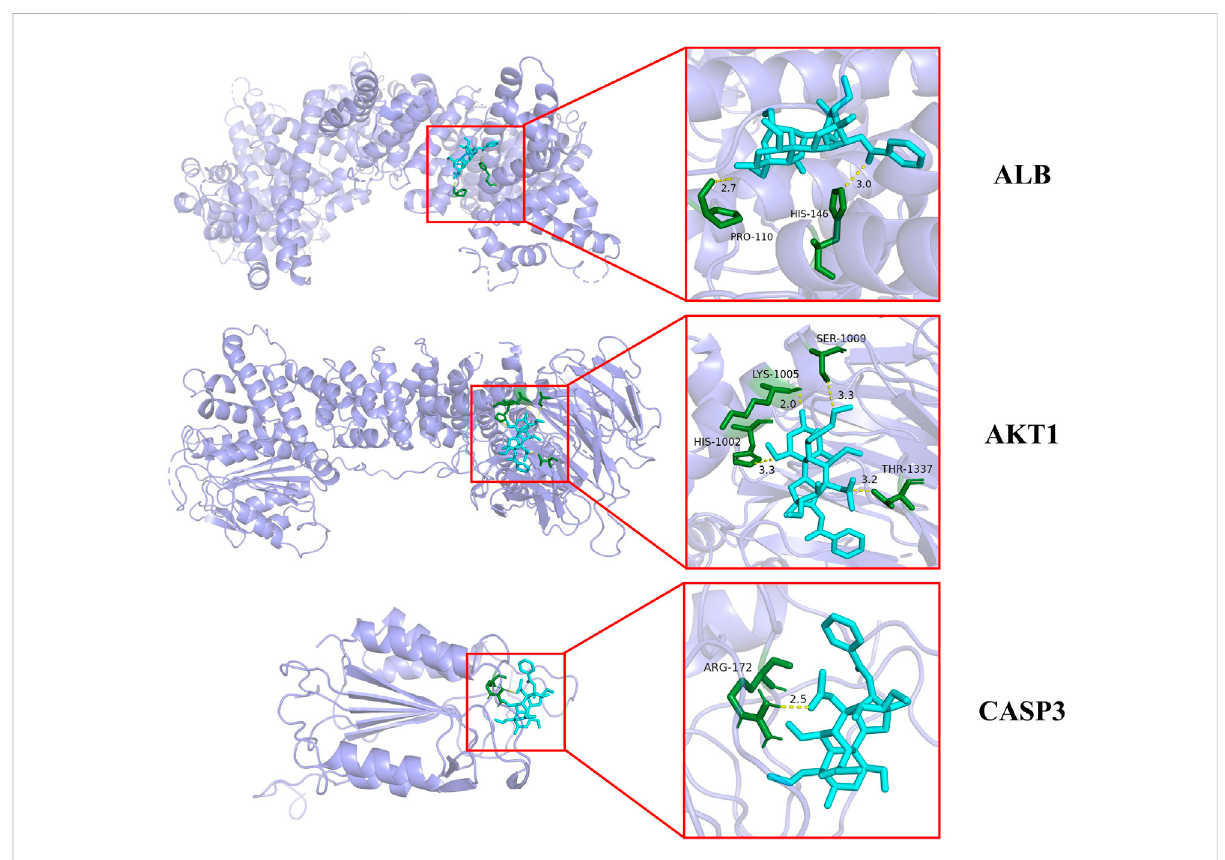
FIGURE 5 Molecular docking patterns of aconitine and core protein molecules. (The yellow lines represent the hydrogen bond interaction force, which is the main force promoting molecule binding with the active site.)